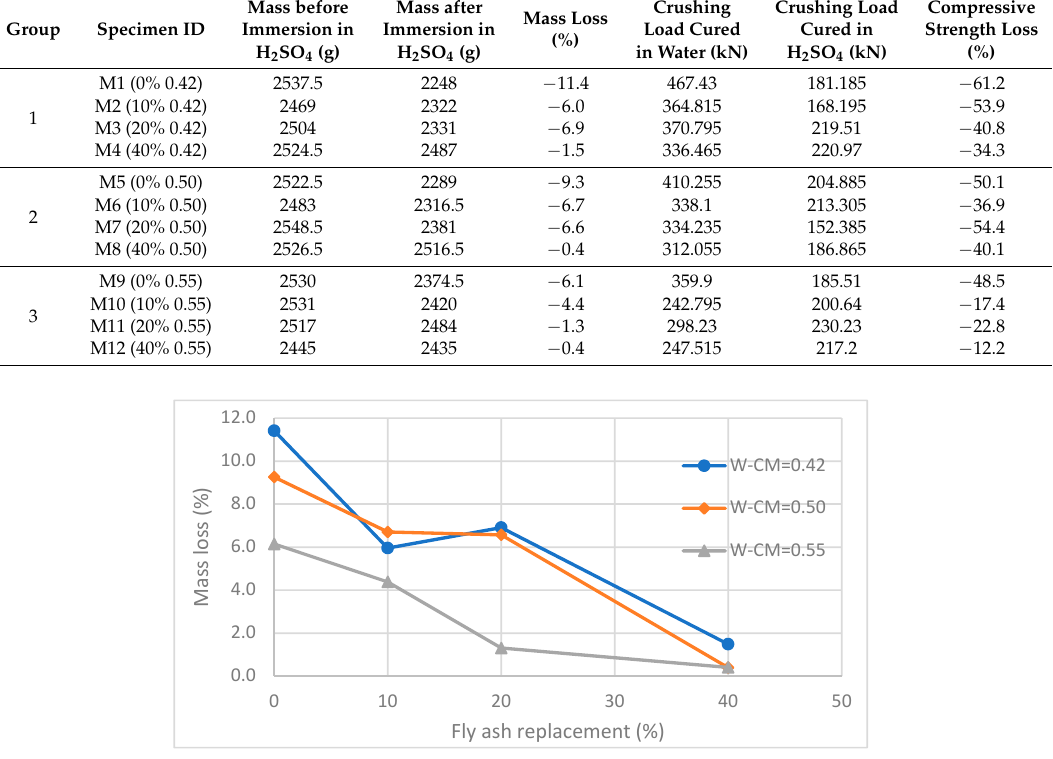
Figure 6. Relationships between mass loss and proportion of fly ash replacement